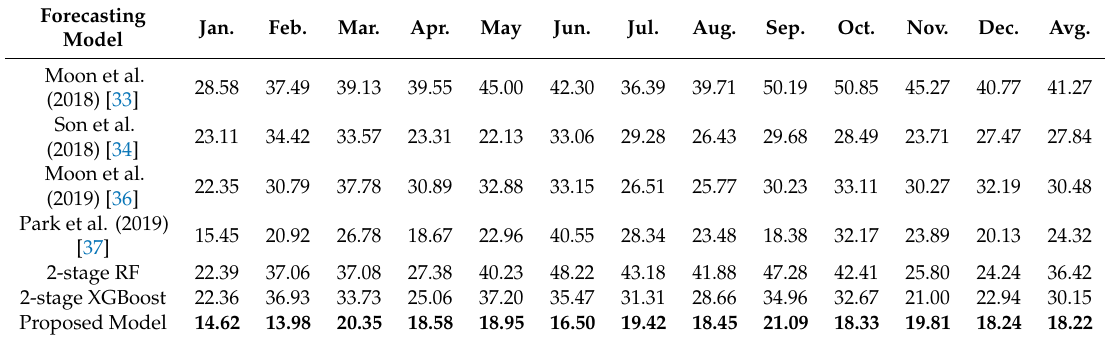
Table 9. MAPE comparison for each month (The best in bold).